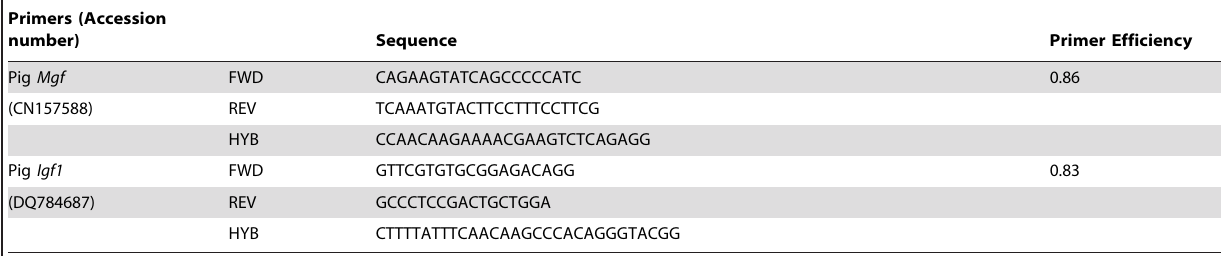
Table 1. Primer sequences for real-time PCR.